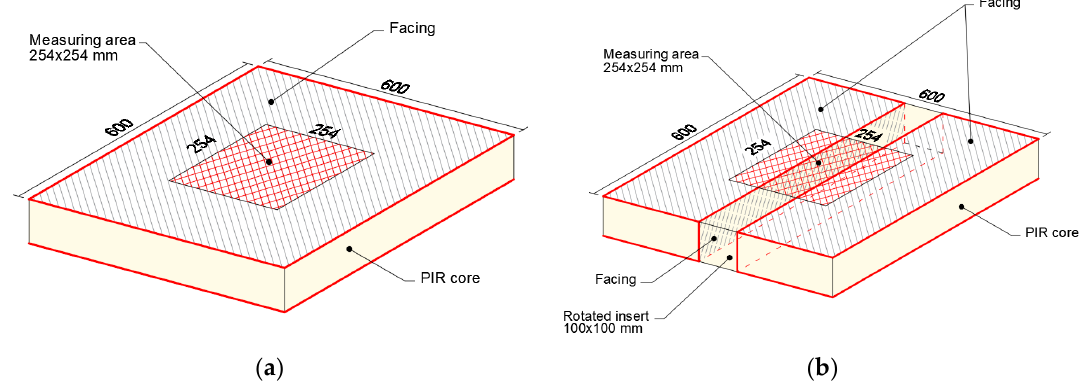
Figure 3. Specimens with a marked measuring area: ( a ) continuous specimen, ( b ) specimen with rotated insert (all the dimensions are expressed in millimeters).